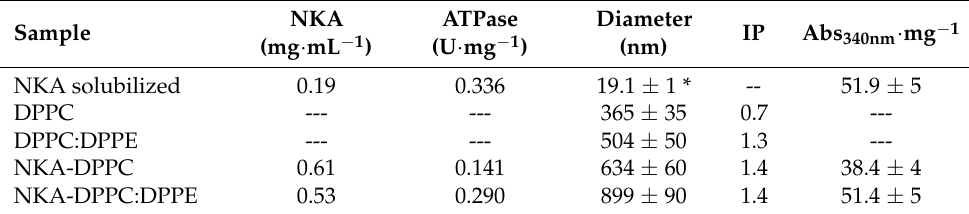
Table 4. Biochemical and biophysical characteristics of NKA solubilized and NKA-liposomes pre- pared in DPPC and DPPC:DPPE. Protein quantification was assayed by Cornelius et al. [65]. ATPase activity was assayed discontinuously at 37 ◦ C by quantifying phosphate release using standard conditions: 50.0 mM HEPES buffer, pH 7.5, containing 3.0 mM ATP, 10.0 mM KCl, 5.0 mM MgCl 2 and 50.0 mM NaCl as described in [62,63,69]. The ability of mineralization was tested in SCL buffer with 2.0 mM of CaCl 2 , in the presence of PS-CPLX nucleator and 48 h of incubation at 37 ◦ C with 3.41 mM ATP as Pi source. Absorbance was measured at 340 nm and normalized by protein concentration in the assay resulting in Abs 340nm · mg − 1